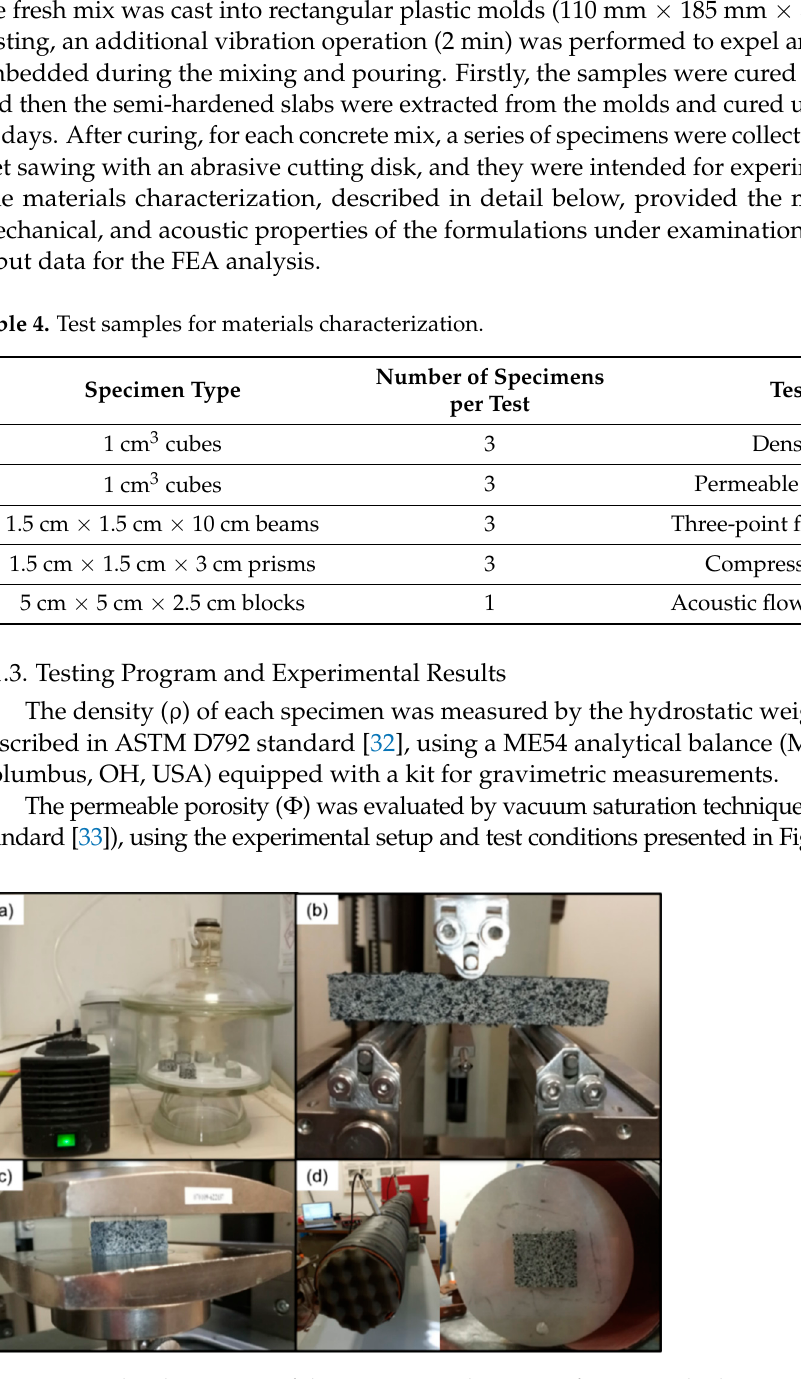
Table 5. Concrete mix proportions.